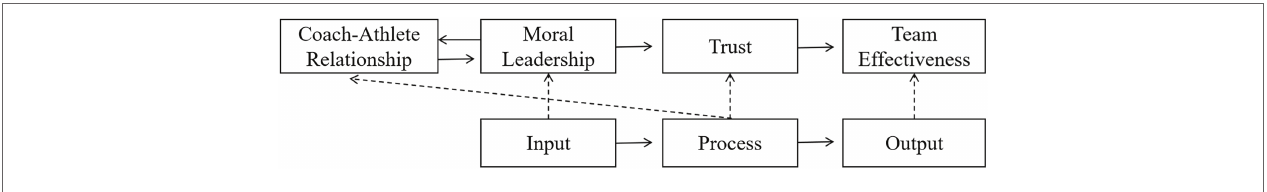
FIGURE 4 | The verified theoretical framework model of this